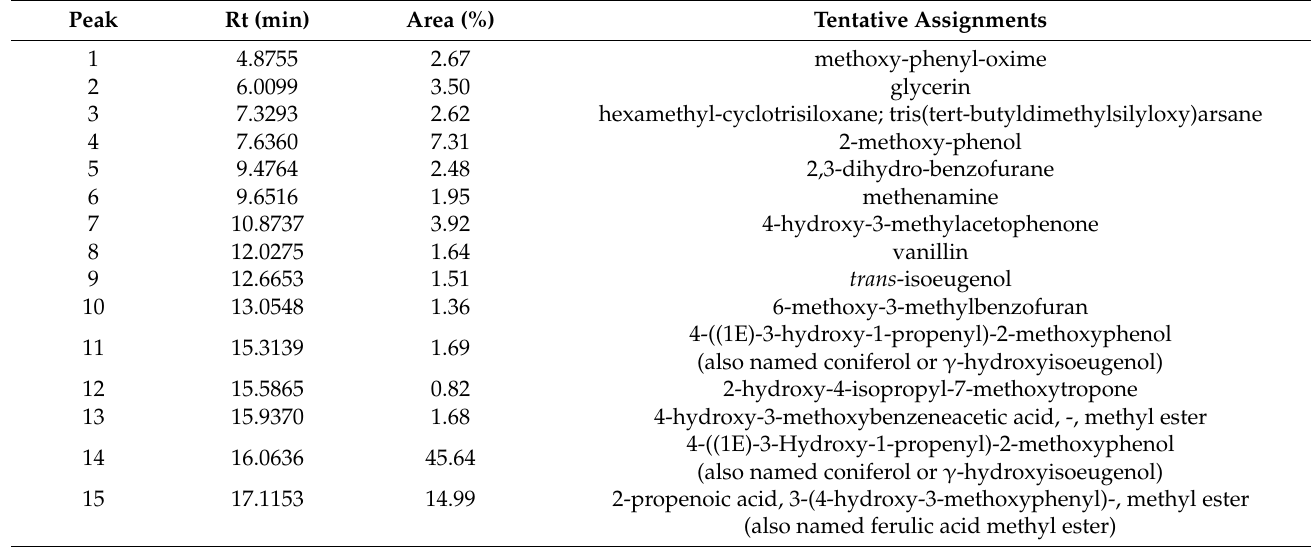
Table 3. Phytochemical compounds identified by GC-MS in the hydromethanolic extract of S. marianum capitula in phenological stage